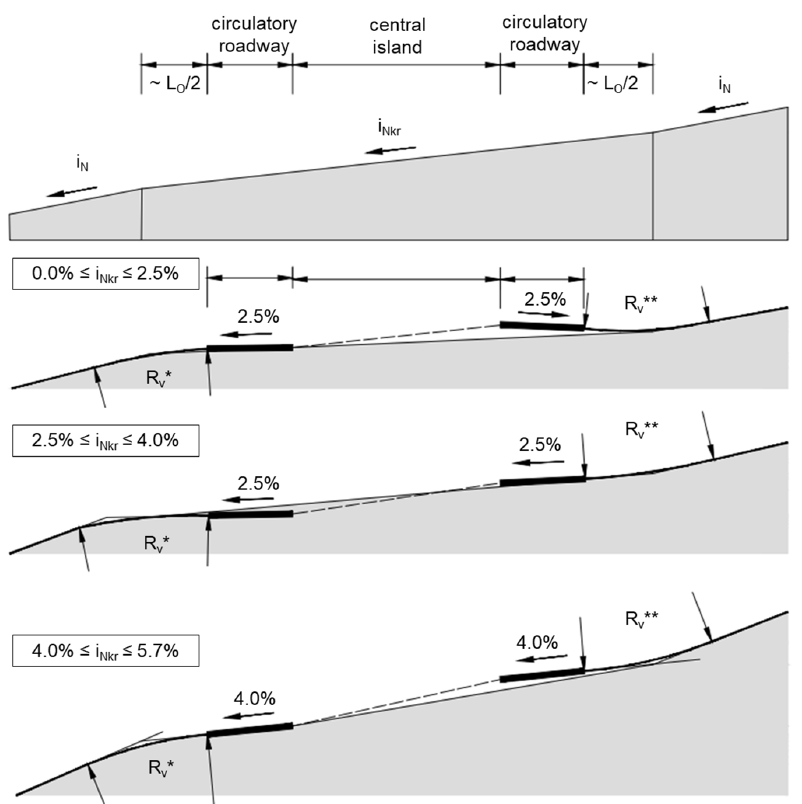
Figure 28. Mitigation of longitudinal slopes on roundabout approaches (Rv*—hog vertical curve